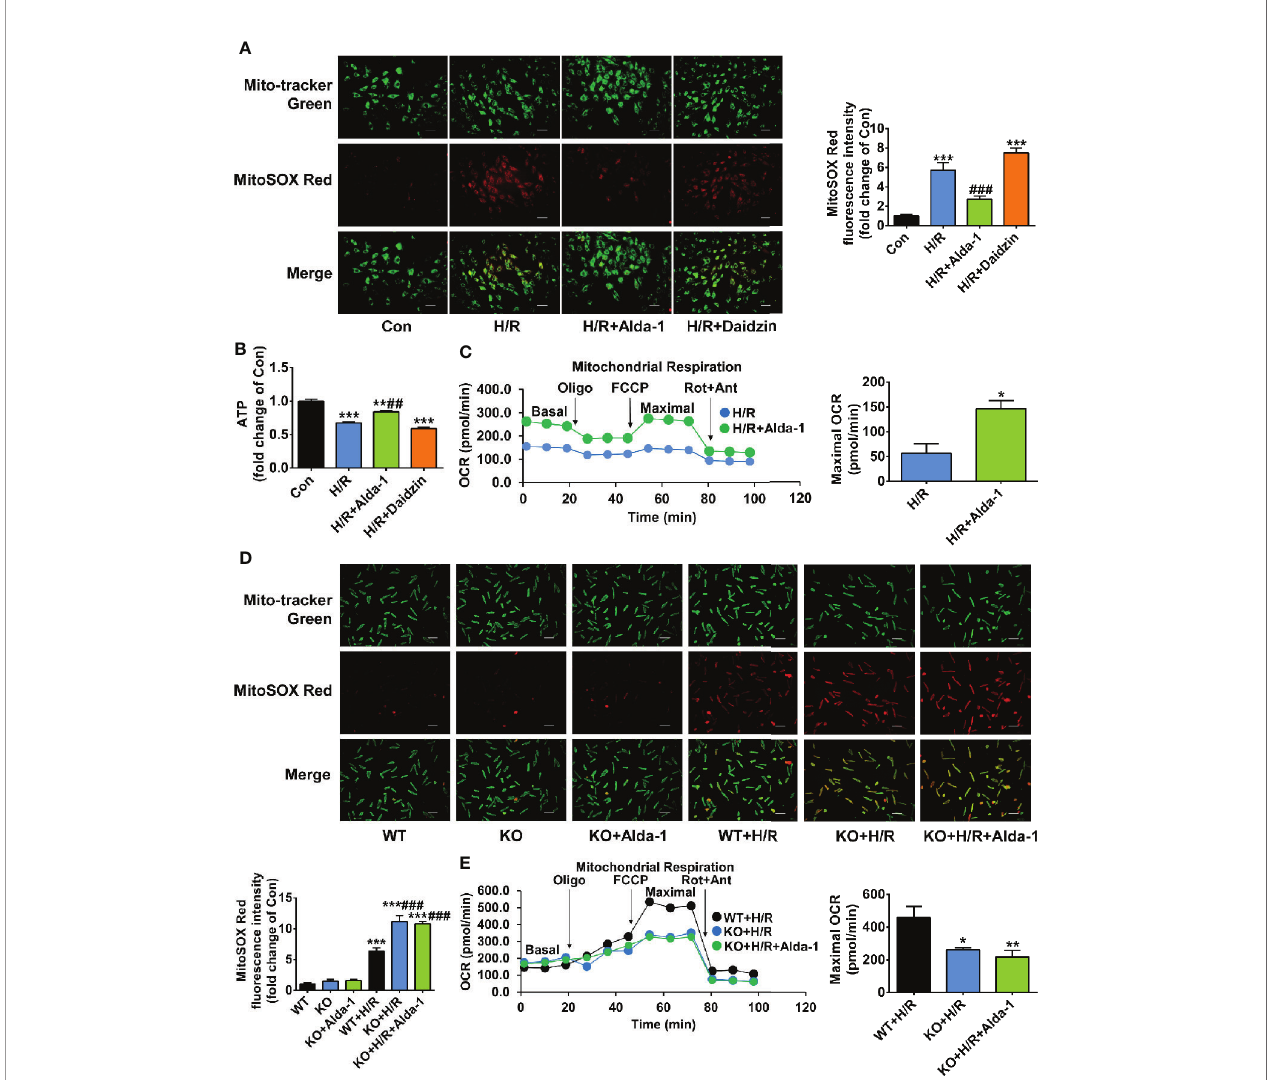
FIGURE 5 | The effect of Alda-1 on mitochondrial ROS levels and mitochondrial energy generation capacity during hypoxia/reoxygenation (H/R). (A – C) Data are from H9c2 cells and are presented as mean ± SEM. (A) Representative photographs and quanti fi cation of mitochondrial ROS levels ( n = 3 samples per group). Scale bar = 250 m m. *** P < 0.001 versus Con group; ### P < 0.001 versus H/R group. (B) The levels of cellular ATP ( n = 3 samples per group). ** P < 0.01, *** P < 0.001 versus Con group; ## P < 0.01 versus H/R group. (C) Mitochondrial respiratory function evaluated by OCR and quanti fi cation of maximal OCR ( n = 3 samples per group). The maximal OCR was calculated by subtracting non-mitochondrial respiration rate (the fi nal rate after Rot/Ant) from the maximal FCCP rate. * P < 0.05 versus H/R group. (D, E) Data are from primary cardiomyocytes isolated from adult male WT mice and ALDH2 KO mice, and are presented as mean ± SEM. (D) Representative photographs and quanti fi cation of mitochondrial ROS levels ( n = 3 samples per group). Scale bar = 250 m m. *** P < 0.001 versus WT group; ### P < 0.001 versus WT+H/R group. (E) Mitochondrial respiratory function evaluated by OCR and quanti fi cation of maximal OCR ( n = 5 – 6 samples per group). * P < 0.05, ** P < 0.01 versus WT+H/R group. Group comparisons were performed by ANOVA with Tukey ’ s post hoc test or Student ’ s